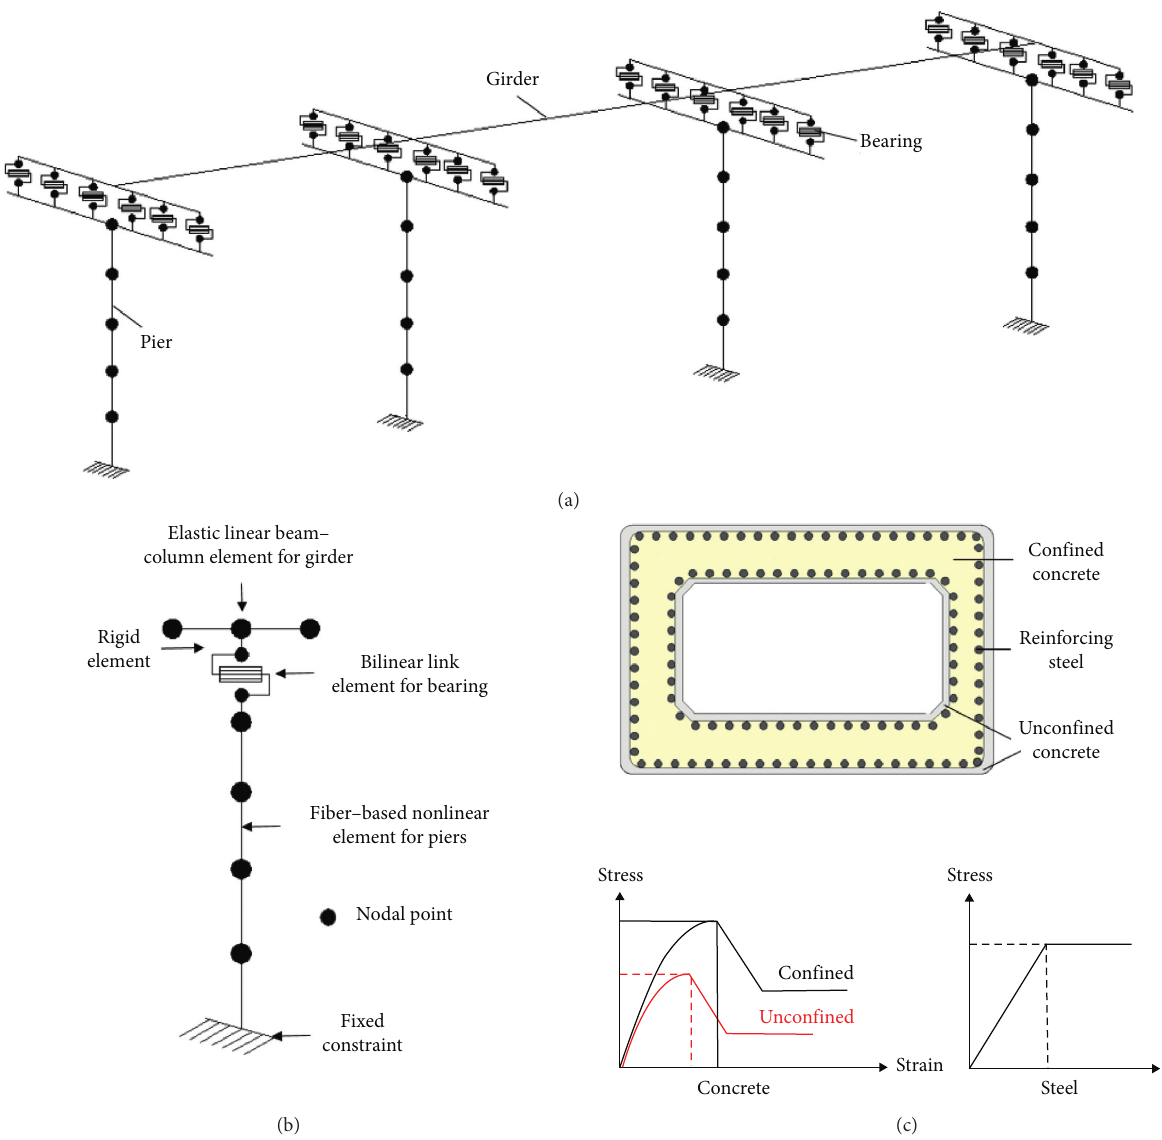
Figure 4: Analytical model: (a) 3-D finite element model of the total bridge system (girder and deck elements are not shown for clarity); (b) modeling details of an external bridge pier including the nonlinear model used for bearings; (c) details of the fibre-based nonlinear elements used for the pier